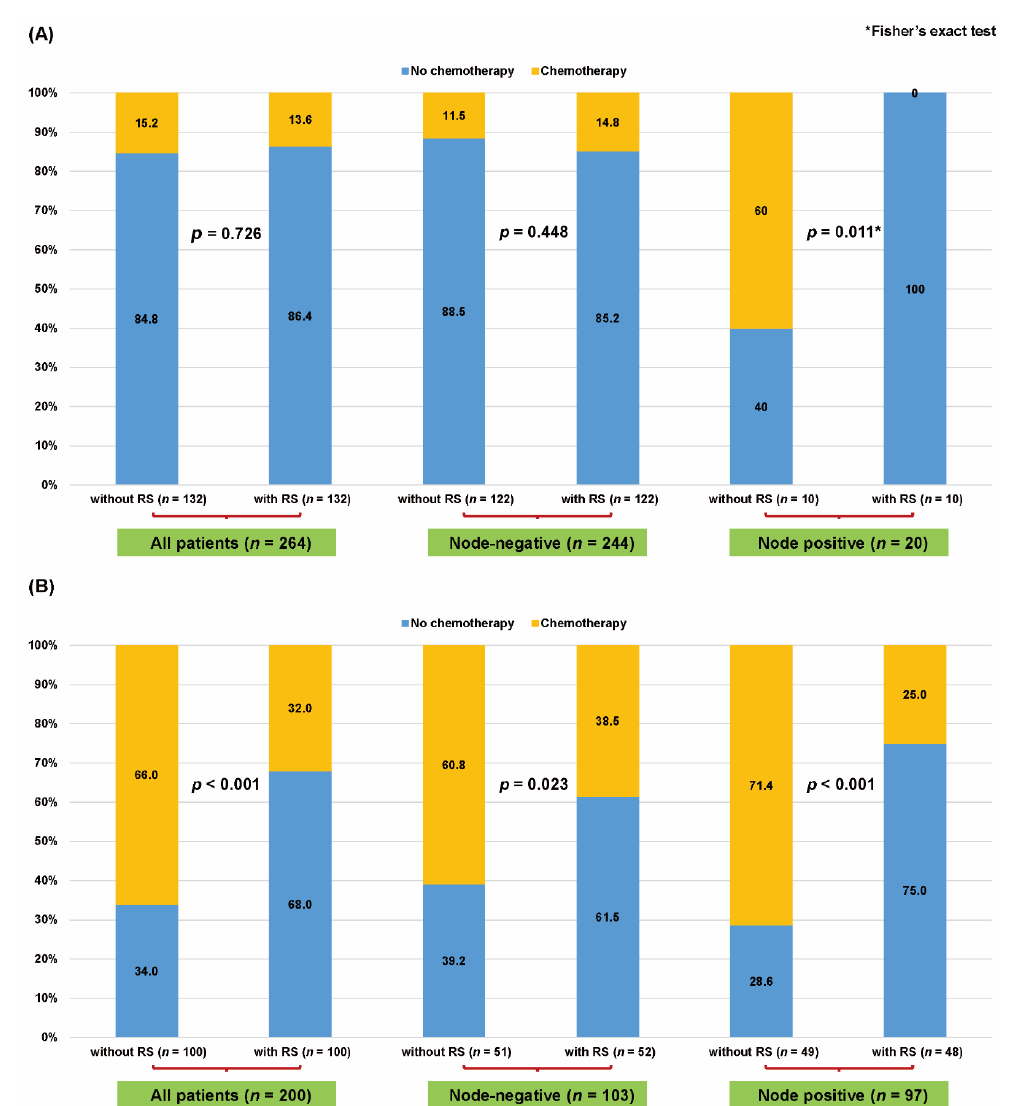
Figure 3. Chemotherapy rates according to the application of the 21-gene Recurrence Score (RS) assay in the propensity- Scheme 21-gene RS assay stratified by clinical risk in patients with ( A ) low clinical risk and ( B ) high clinical risk. Chi-square test, significance level 0.05. * Fisher’s exact test, significance level of 0.05.